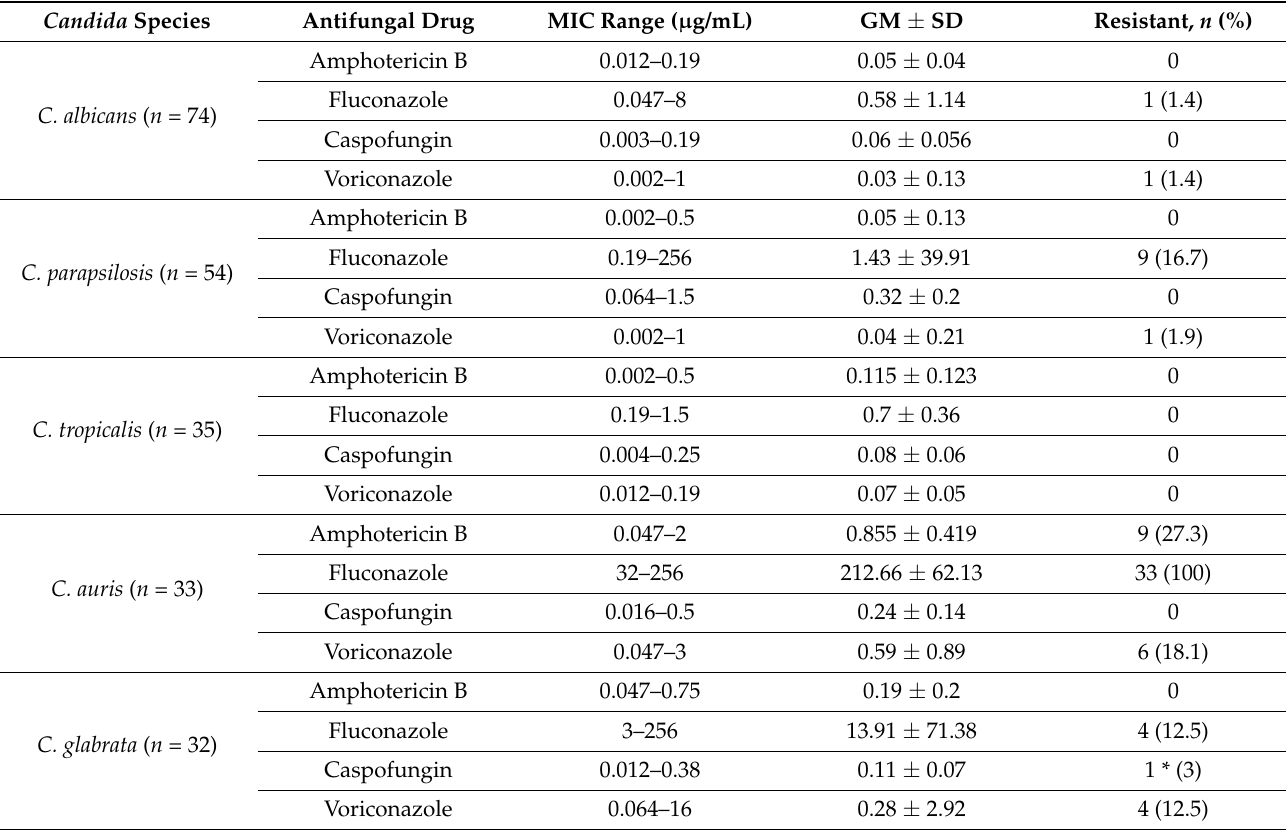
Table 6. Antifungal Susceptibility Data of Candida Species Isolates against Four Antifungal Drugs by Etest. Candida